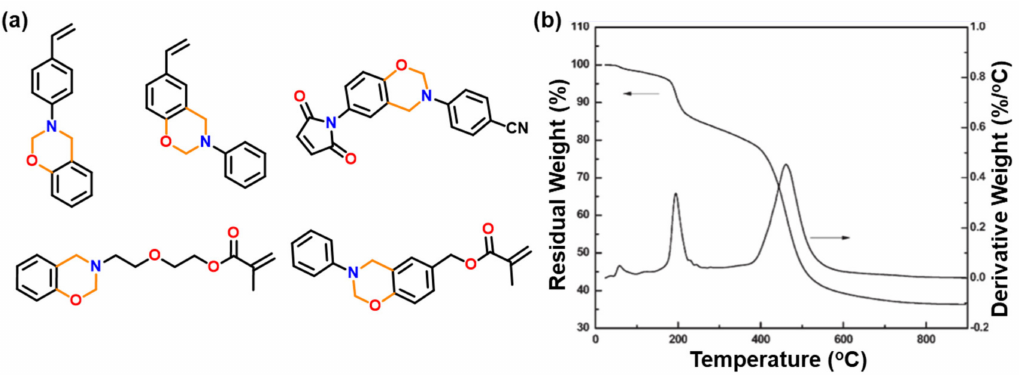
Figure 23. ( a ) Representative photopolymerizable benzoxazine containing monomers [228,229] and ( b ) TGA curve of methacryloyl-benzoxazine monomer [228]. Copyright 2011. Reproduced with permission from American Chemical